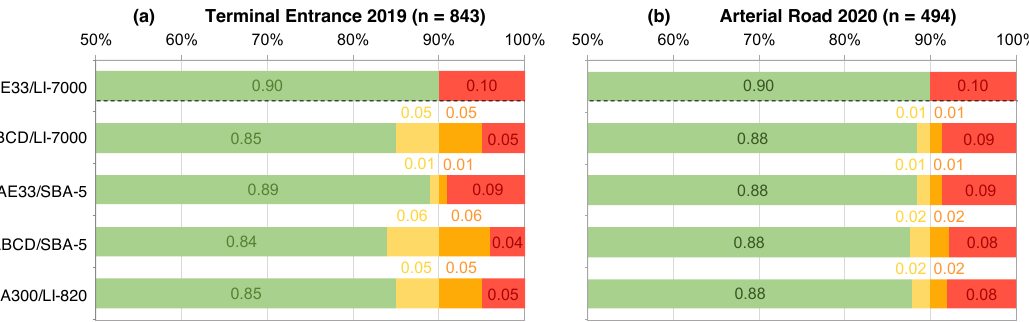
Figure 3. Agreement of high emitter classification across three di ff erent sensor pairs for the ( a ) Terminal Entrance and ( b ) Arterial Road fleets. Classifications are compared to the AE3 / LI-7000, and labeled as a high emitter (red) or not a high emitter (green) as well as a false positive (yellow) or negative (orange). Each bar adds up to 100% of the sampled